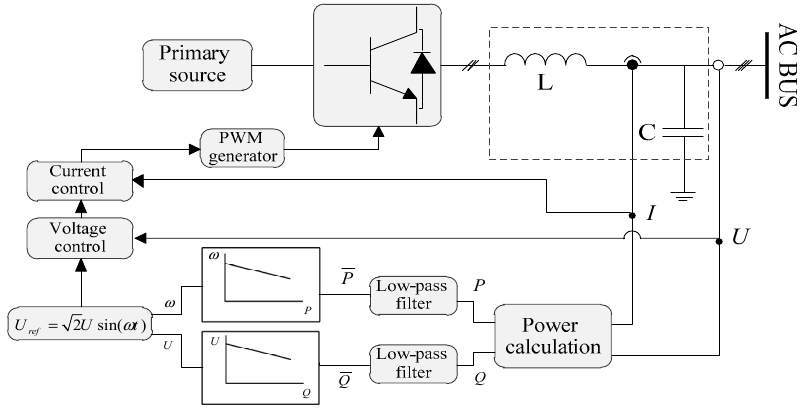
Figure 2. Structure of a grid-forming converter control system. PWM: Pulse width modulation.